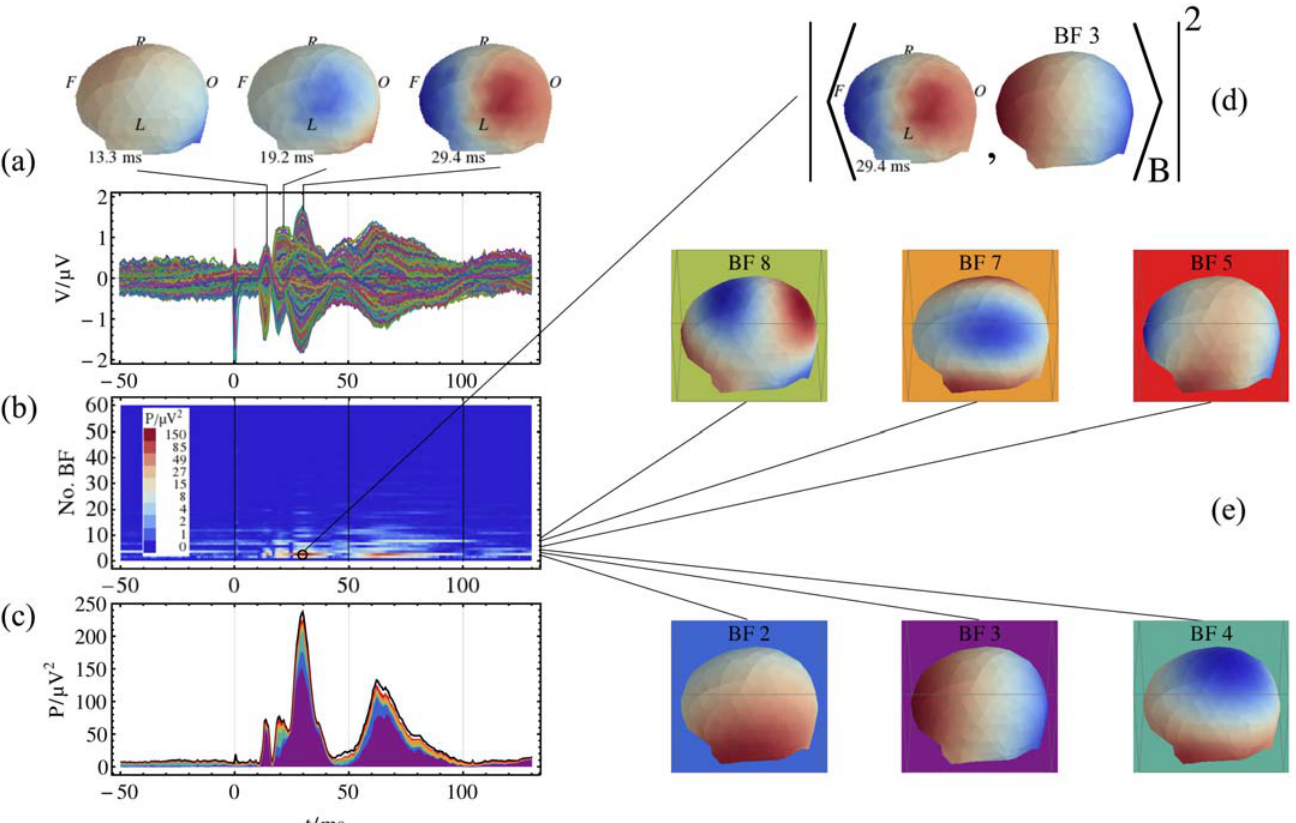
Fig 5. The spatial harmonic decomposition of the SEP data for one volunteer. (a) Averaged trials of the SEP data, 256 channels and the potential distribution for P14, N20, and N30 are shown. The view direction is top left. (b) Time-spatial-harmonic representation of the power of the SEP data using 60 BF with the lowest frequencies, starting with the low frequency at the bottom. (c) Contribution of selected BF to the MGFP of the SEP data. The MGFP is represented by the black line. The contribution of the BF is color-coded in the background, compare subfigure (e). (d) For each point of the time-spatial- harmonic representation, the square of the absolute value of the B -related inner product between the potential distribution and the BF is computed. (e) Selection of BF used for the data decomposition; note the different color scaling for each BF; the color code of the background is used in subfigure (c).